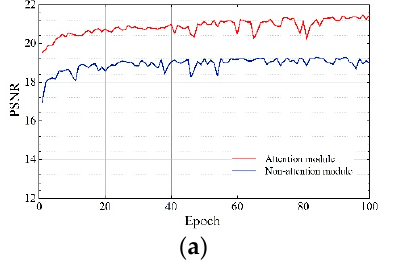
Figure 6. Effects of ablation study (1). Table 3. Average PSNR/SSIM of ablation study (1).